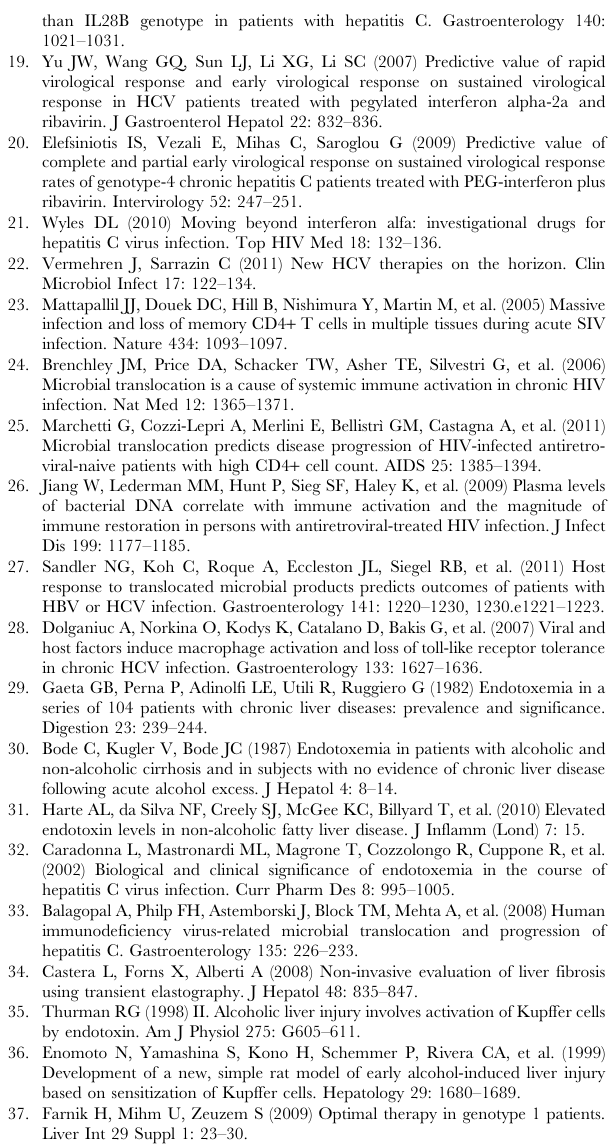
Table S2 Association between markers of microbial translocation and Sustained Virological Response to anti-HCV treatment on patients on HAART. Univariate and multivariate logistic regression conducted including only HIV/HCV patients on HAART (n 96) to explore association between markers of microbial translocation (sCD14 and LPS) and SVR. The multivariate analysis is adjusted for demographic, HCV- and HIV-related variables. LPS, soluble CD14, CD4 + T cells/ m L, age, HCV-RNA log 10 cp/mL for each unit more. sCD14 and LPS were measured in plasma samples; sCD14 m g/mL, LPS pg/mL. OR, odds ratio; AOR, adjusted odds ratio; CI, confidence interval. p . 0.05 was considered non